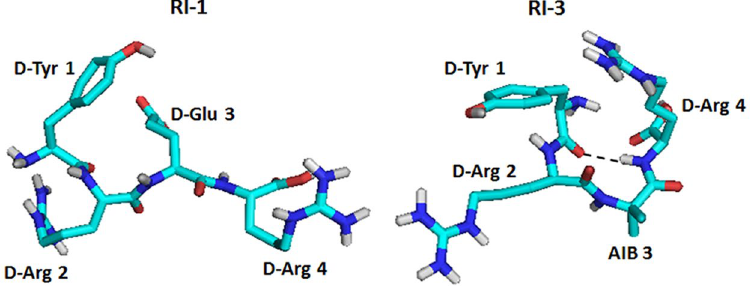
Figure 3. Conformational analysis on Retro-Inverso Peptides. Shown is the average conformation for RI-1 (left) and RI-3 (right) obtained during the MD simulations. In RI-3, the hydrogen bond between the CO group of D-Tyr1 and the NH group of D-Arg4 is shown as a dashed